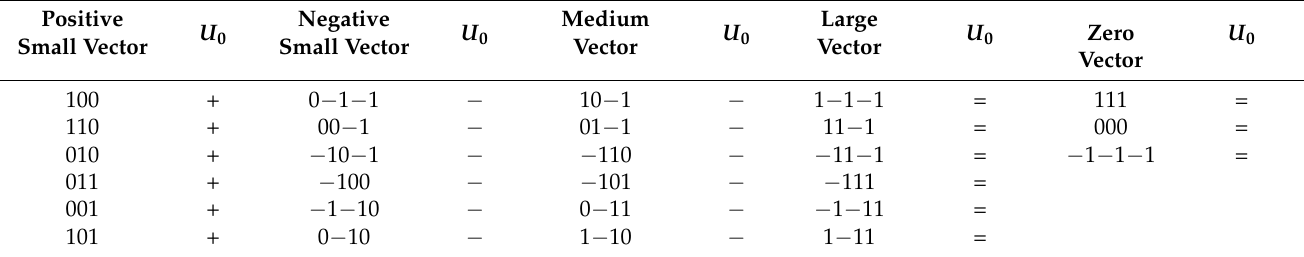
Table 1. The effects of different switching vectors on the